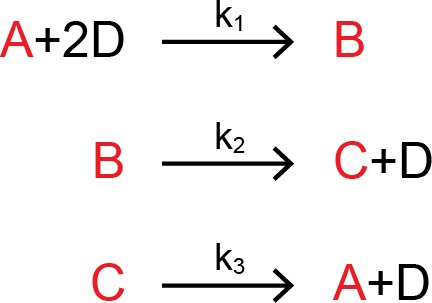
Reaction set corresponding to protein network.